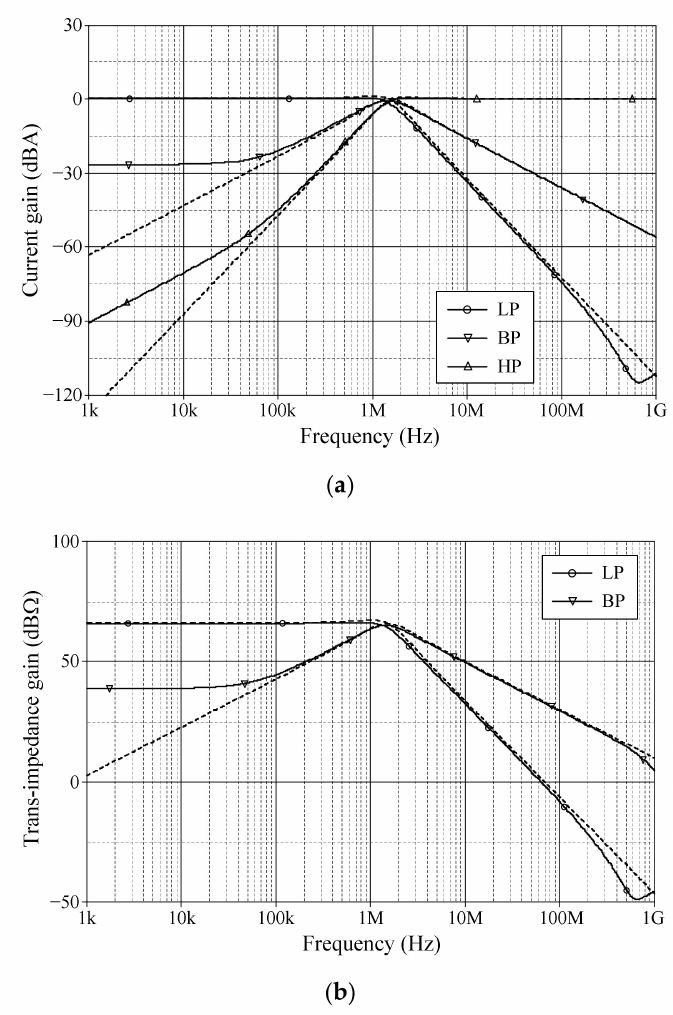
Figure 7. Ideal (dashed line) and simulated (solid line) frequency responses for CM and TIM: ( a ) LP, BP, HP in CM; ( b ) LP and BP in TIM.